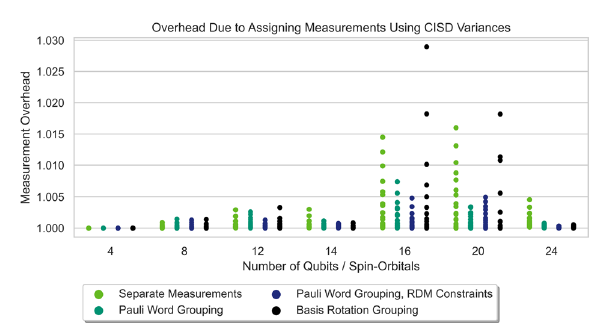
Fig. 2 The overhead in measurement time incurred by using a sub-optimal distribution of measurement effort. Speci fi cally, the increase in the time (or the number of circuit repetitions) required to measure the ground state energy to a fi xed precision when the measurements are distributed between groups using the variances calculated with the con fi guration interaction singles and doubles (CISD) approximation rather than the true ground state. For each of the systems and measurement techniques considered in this work, we present the ratio of the time required when using this approximate distribution of measurement repetitions compared with the time required using the optimal distribution, both calculated using Eq. (5) and then applied to the measurement of the actual ground state of the system. We fi nd that using a classically tractable CISD calculation to determine the distribution of measurements between groups results in only a small increase in total measurement time.